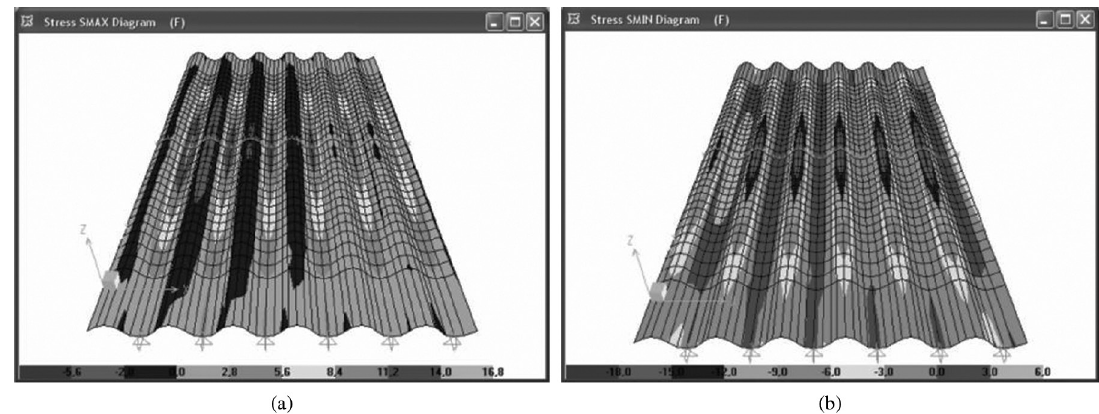
Figure 14. Stresses in the model with span of 1530 mm: (a) Maximum value of tension ( σ Maximum value of compression ( σ ) in the upper surface of the high wave. min